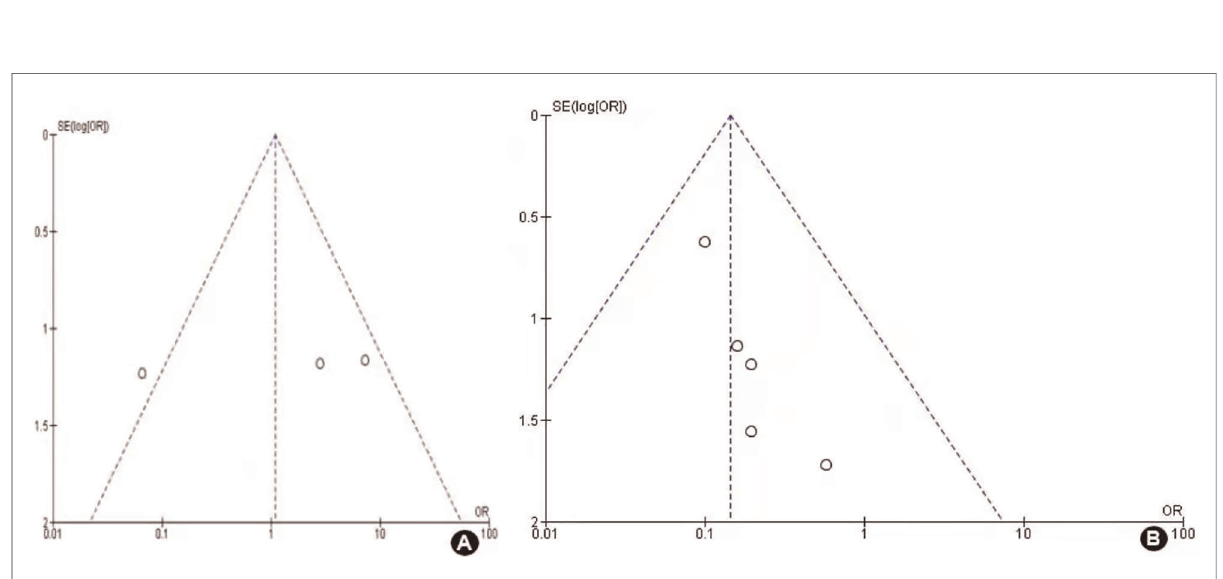
FIGURE 5 Funnel plot for publication bias, 4A. Five year survival rate, 4B. Local